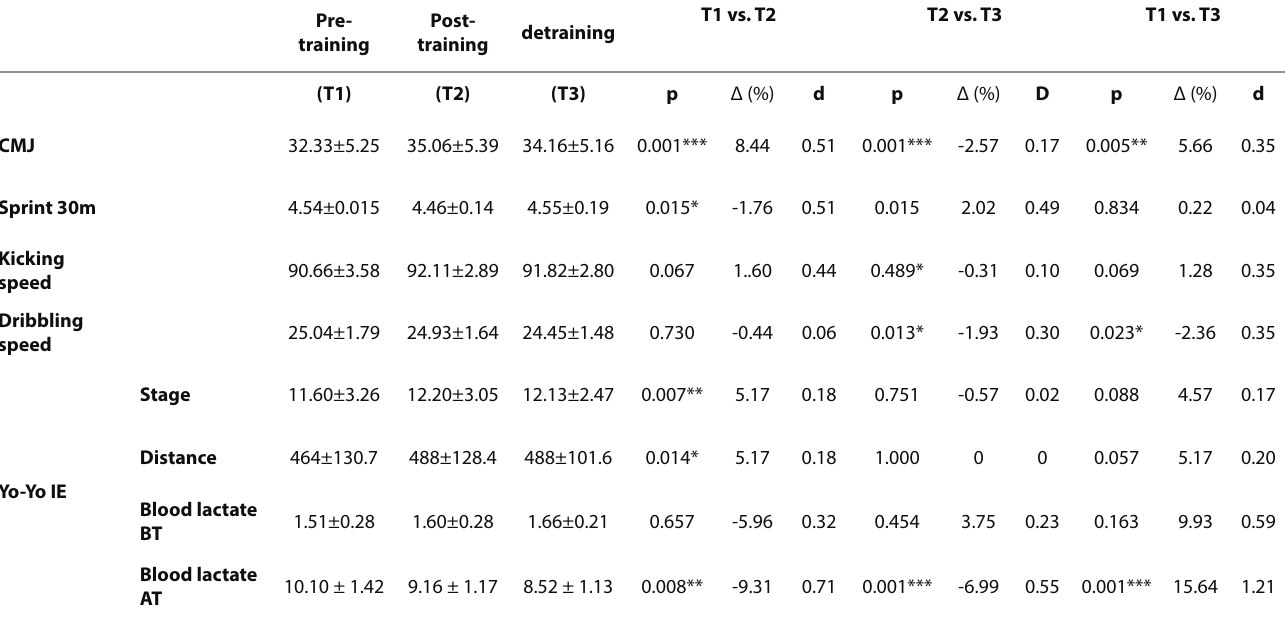
TABLE 2. Comparison between the three moments